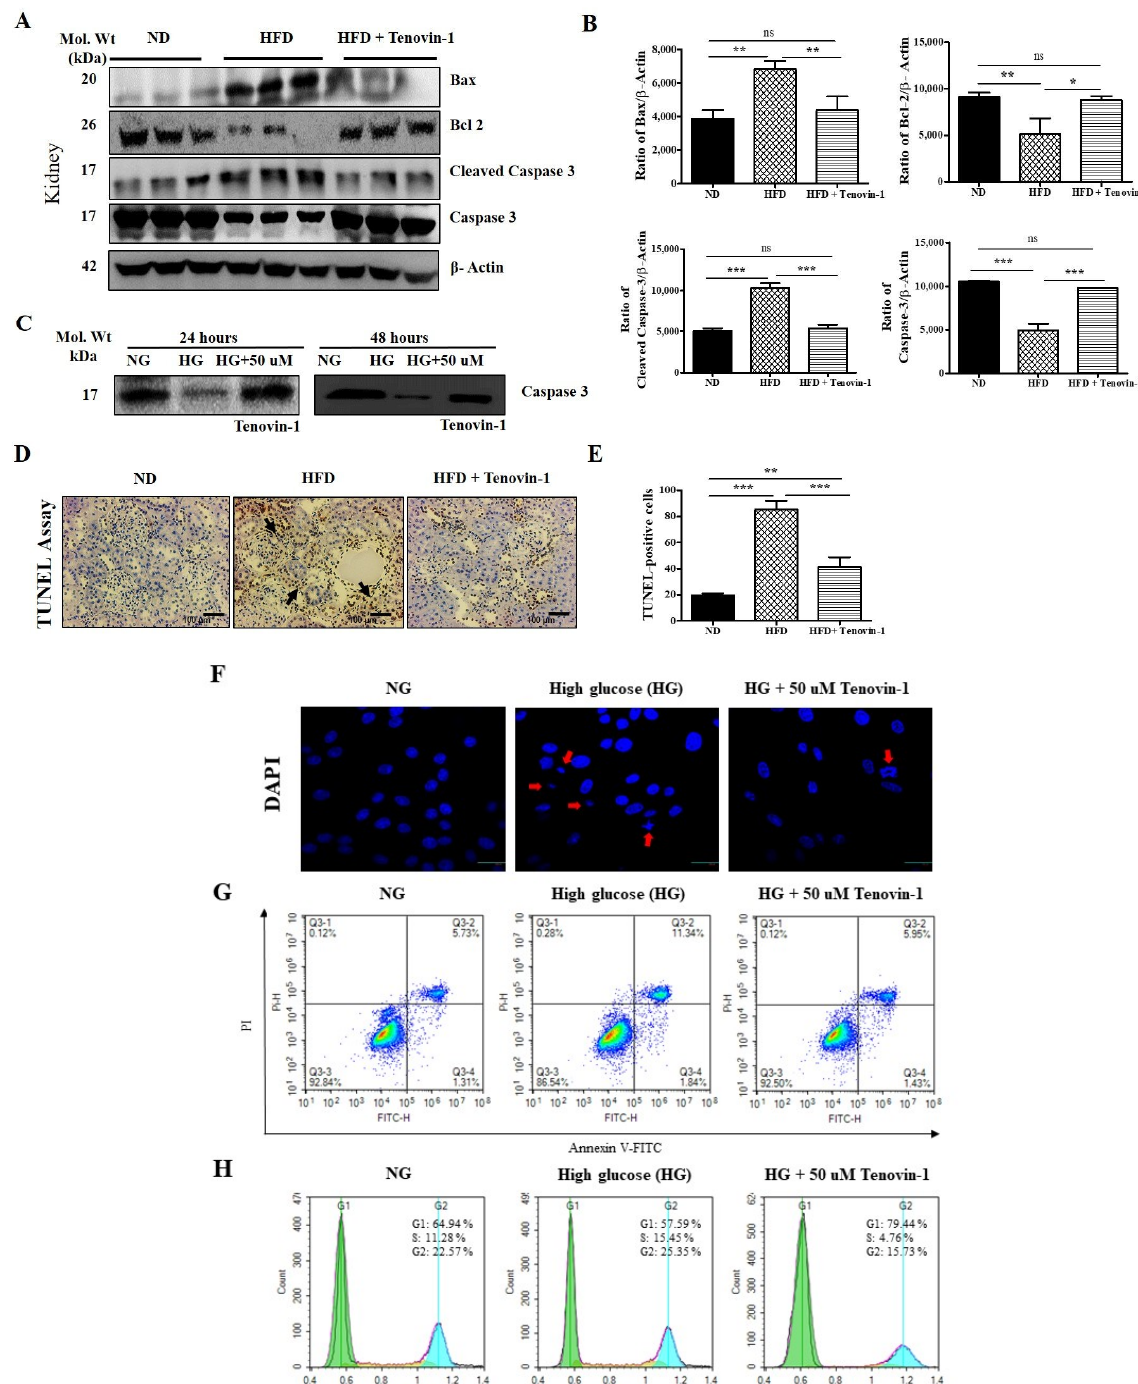
Figure 7. Effects of Tenovin ‐ 1 on the expression of proteins linked to apoptosis in the kidney tissue of diabetic rats fed a high ‐ fat diet. ( A ) The levels of expression of Bax, Bcl2 , cleaved caspase ‐ 3, and caspase ‐ 3 were analyzed via Western blot analysis using experimental rat models of HFD ‐ induced diabetes. β‐ actin was used as the loading control. ( B ) Using Image J software, the band intensities were densitometrically quantified. ( C ) Western blot analysis of caspase ‐ 3 for NRK ‐ 52E cells. ( D ) Apoptosis was analyzed by TUNEL staining of the kidney tissues from HFD ‐ fed rats. Original magnification: 200×; scale bar: 100 μ m. ( E ) Determined TUNEL ‐ positive score index. ( F ) Representative 4 ′‐ 6 ‐ diamidino ‐ 2 ‐ phenylindole (DAPI) staining to assess apoptotic cell death. ( G ) Analysis of apoptotic (Annexin V/PI) assay to determine the proportions of late ‐ stage apoptotic cells. ( H ) Flow cytometry analysis for cell cycle profiles in high ‐ glucose ‐ induced NRK ‐ 52E cell